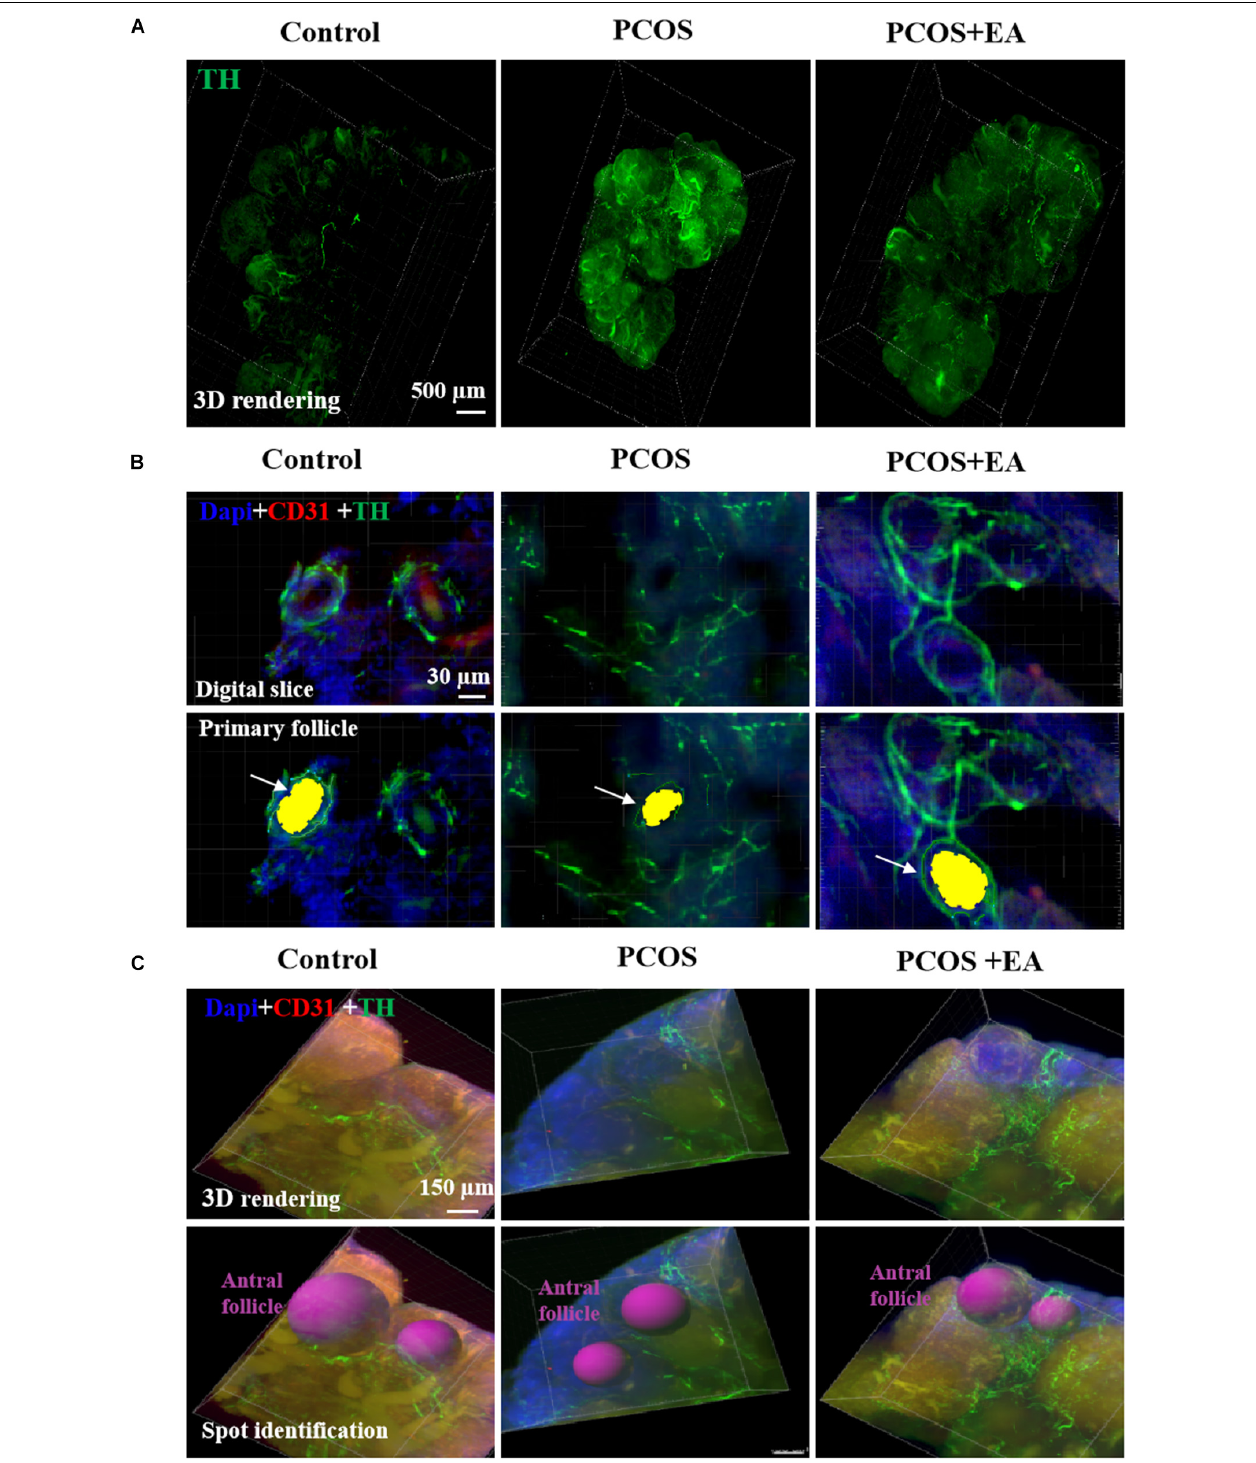
FIGURE 4 | PCOS ovaries showed increased innervation in the ovarian stoma and decreased nerve fibers surrounding the antral follicles, and this was reversed following EA. Ovaries from the three groups were obtained for innervation and blood vessel staining using TH and CD31, respectively. (A) Ovarion innervation of the three groups. (B) Ovarian innervation of primary follicles. Individual follicles in the three groups were stained using DAPI (blue) together with antibodies against CD31 (red) and TH (green) for identification of blood vessels and neurons, respectively, using the Imaris software. The primary follicle is shown in yellow indicated by arrow. (C) Distribution of the neurovasculature surrounding antral follicles, which are marked in red.